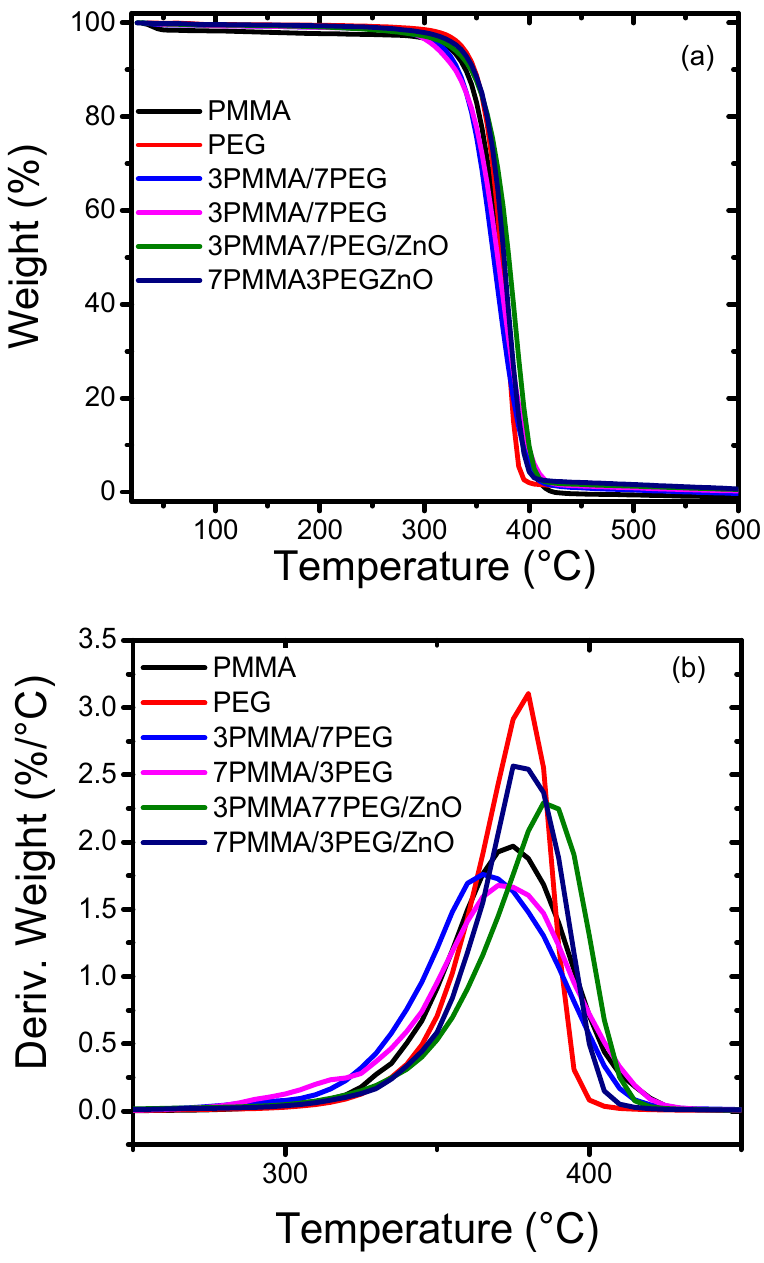
Figure 8. Thermogravimetry ( a ) and derivative thermogravimetry ( b ) curves of neat polymers (PMMA and PEG), polymer blends (7PMMA3PEG and 3PMMA7PEG) and nanocomposite blends (7PMMA/3PEG/ZnO and 3PMMA/7PEG/ZnO). Table 4. Thermal stability of neat polymers, blends and nanocomposites by thermogravimetry. Samples